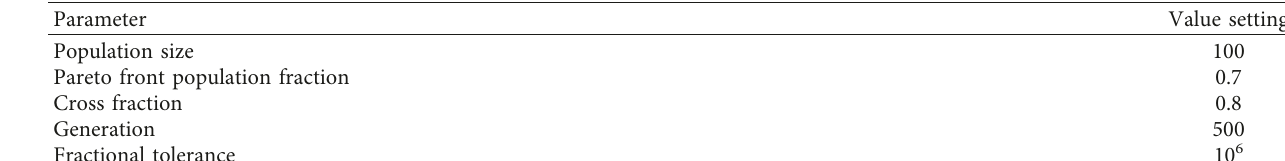
Table 6: Parameter setting for GA.